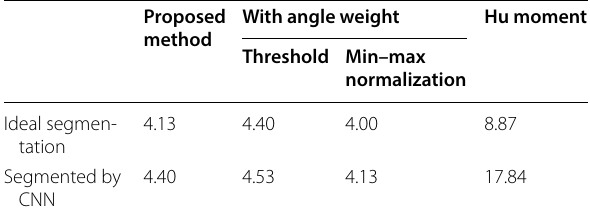
Table 1 Error when aligning with each method